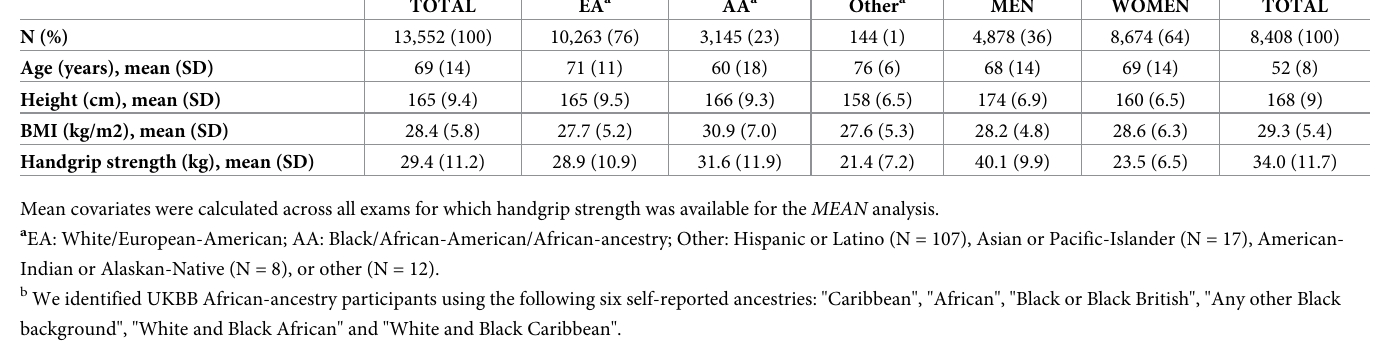
Table 1. Description of the 13,552 TOPMed participants included in the main pooled whole genome sequence association analysis of MEAN handgrip strength and the 8,408 UK Biobank participants used for replication.